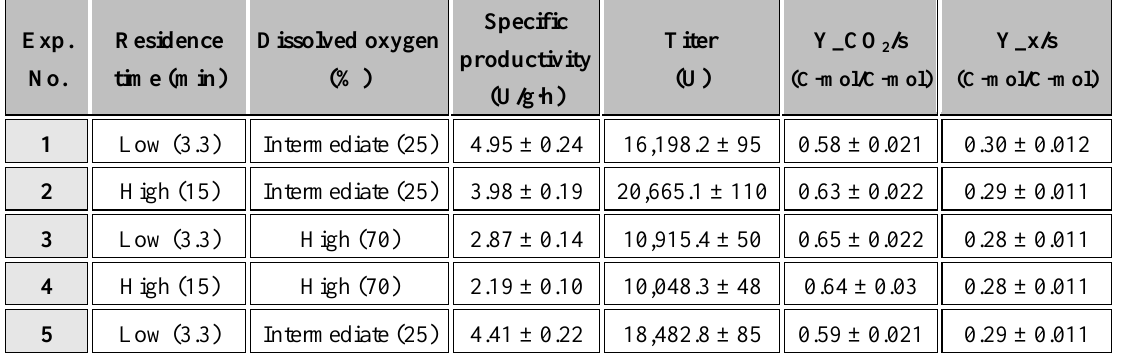
Table A1. All responses to be modeled (value and standard deviation) for DoE 1. Exp.